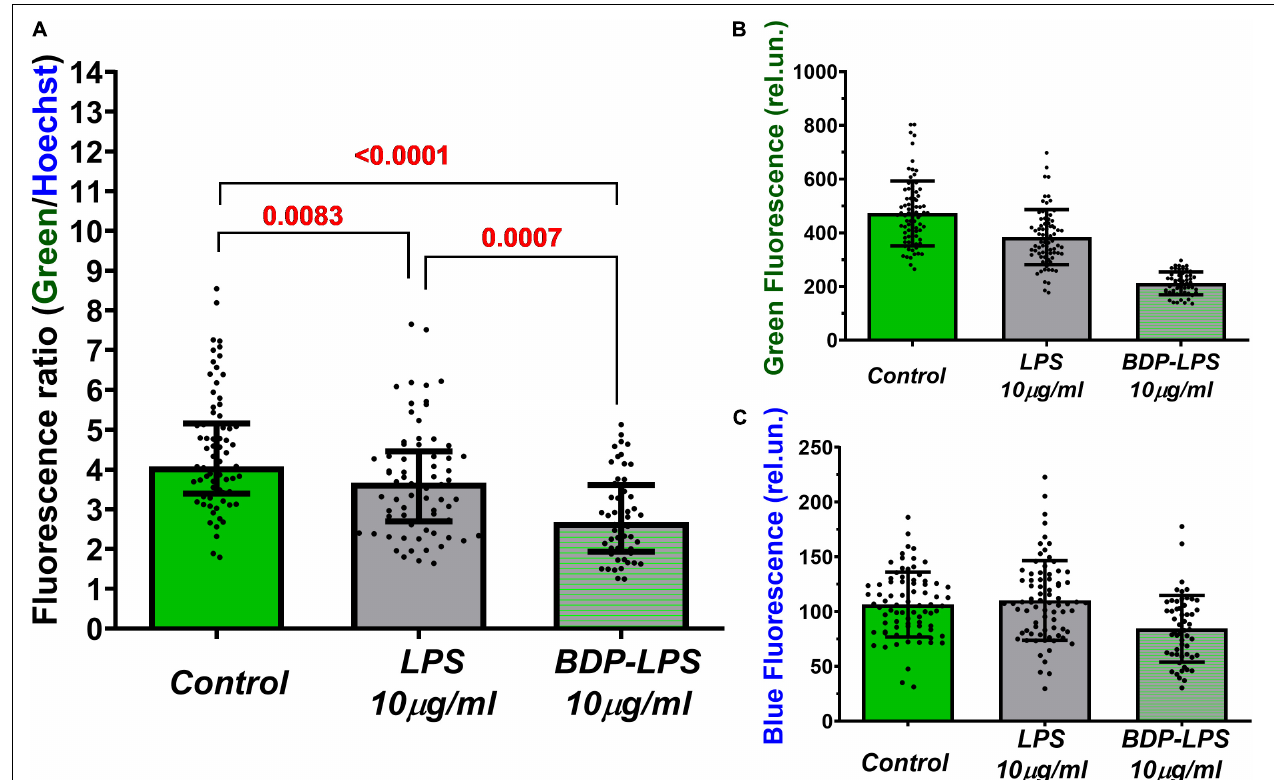
FIGURE 8 | Mean values of green (A) and blue (B) fluorescence, and the ratio of green/blue fluorescence intensities (C) of cultured cortical neurons with or without BDP-LPS incubation (5,5 h). Green autofluorescence was observed in Control and LPS-treated cultures, as well as incubation with a fluorescently labeled analog of LPS (BDP-LPS). The blue fluorescence belongs to the nuclear dye Hoechst33342. BDP-LPS contains a fluorophore BDP in the lipopolysaccharide moiety of LPS (in the O-antigen). Hoechst33342. Green 525 nm fluorescence was excited at 485 nm light. Hoechst33342 blue fluorescence is represented in red for better contrast (excitation: 380 nm; emission: 460 nm). Fluorite lens 20 × /NA = 0.70. Images were recorded using Andor NEO CSMOS camera; exposure time: 3200 and 200 ms for green and blue fluorescence, respectively. Median ± interquartile range. Statistically significant differences were determined according to the Kruskal-Wallis test with Dunn’s multiple comparisons